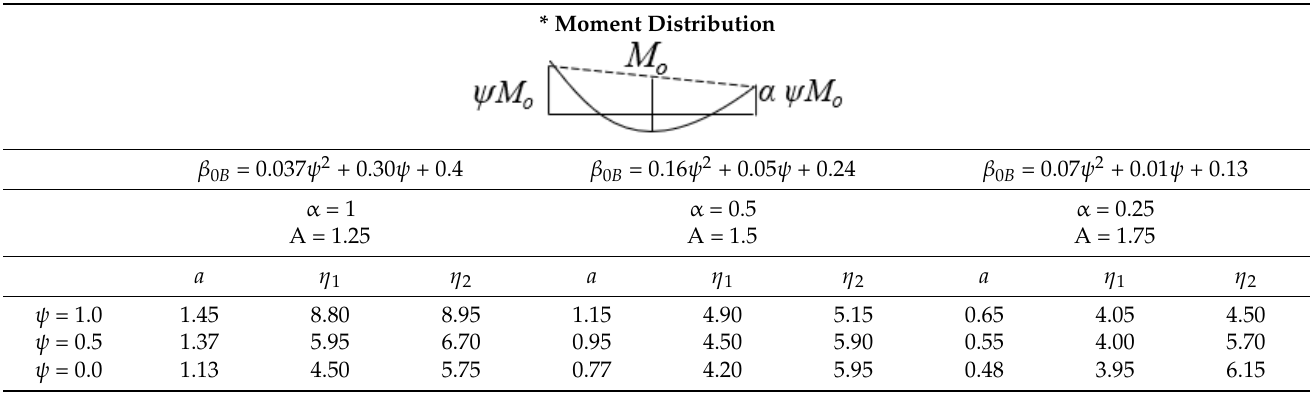
15 of 37 Table 6. Approximate determination of the elastic critical moment for members with concentrated load and end moments. Adapted from Hanswille et al. [117]. * Moment Distribution β 0B = 0.320 ψ + 0.53